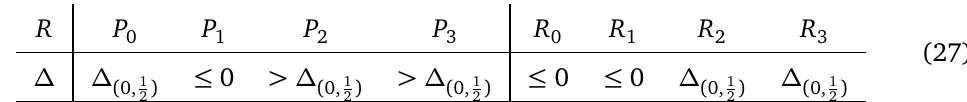
→ z , such that these quantities 1 2